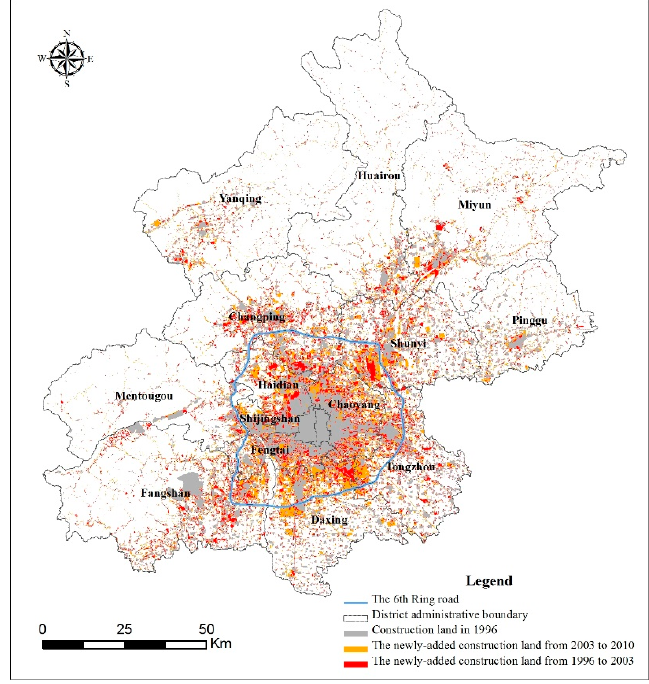
Table 1. Urban land area changes in Beijing.